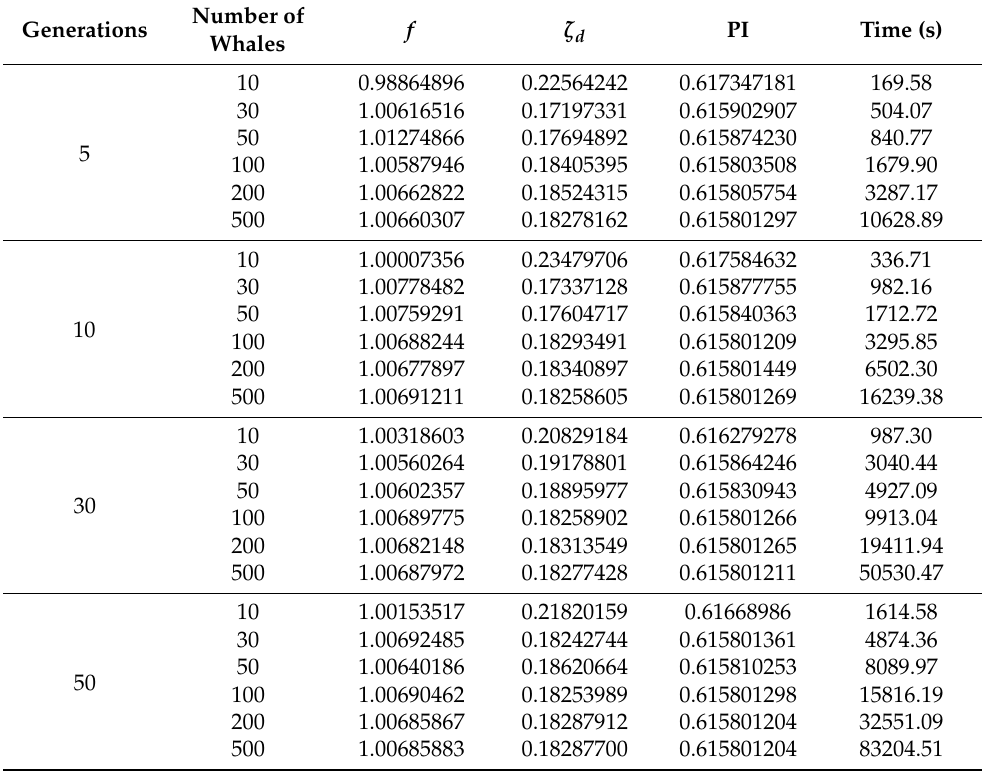
Table 2. Complementary information on the calibration process.